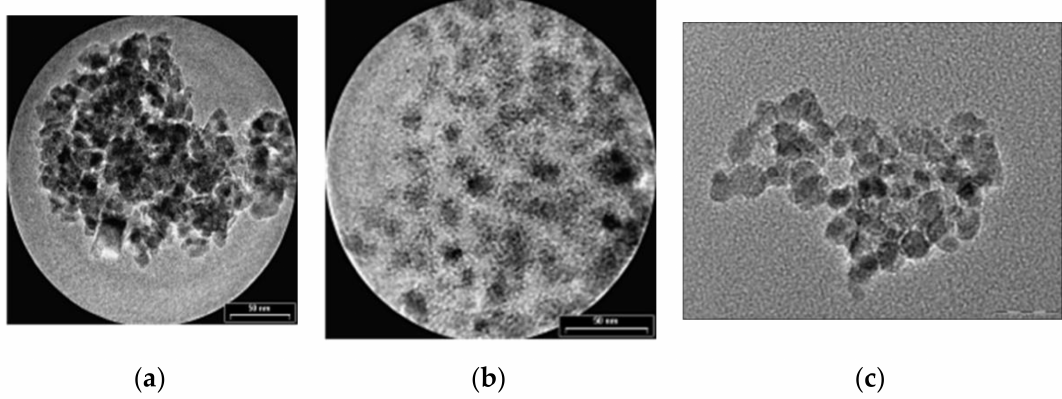
Figure 6. TEM images of Fe 3 O 4 MNPs: ( a ) unfunctionalized MNPs (average medium size of particles 8.5 ± 2 nm); ( b ) citrate-functionalized MNPs (average medium size of particles 9.5 ± 1 nm); ( c ) phosphate-functionalized